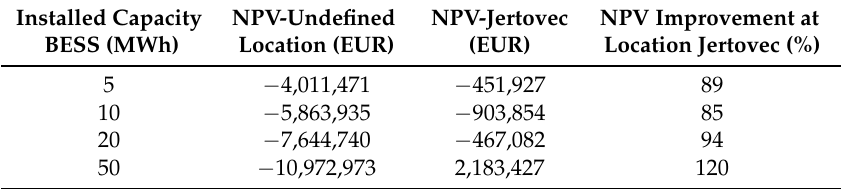
Table 5. NPV indicators 50% reduced BESS investment cost: undefined location and location